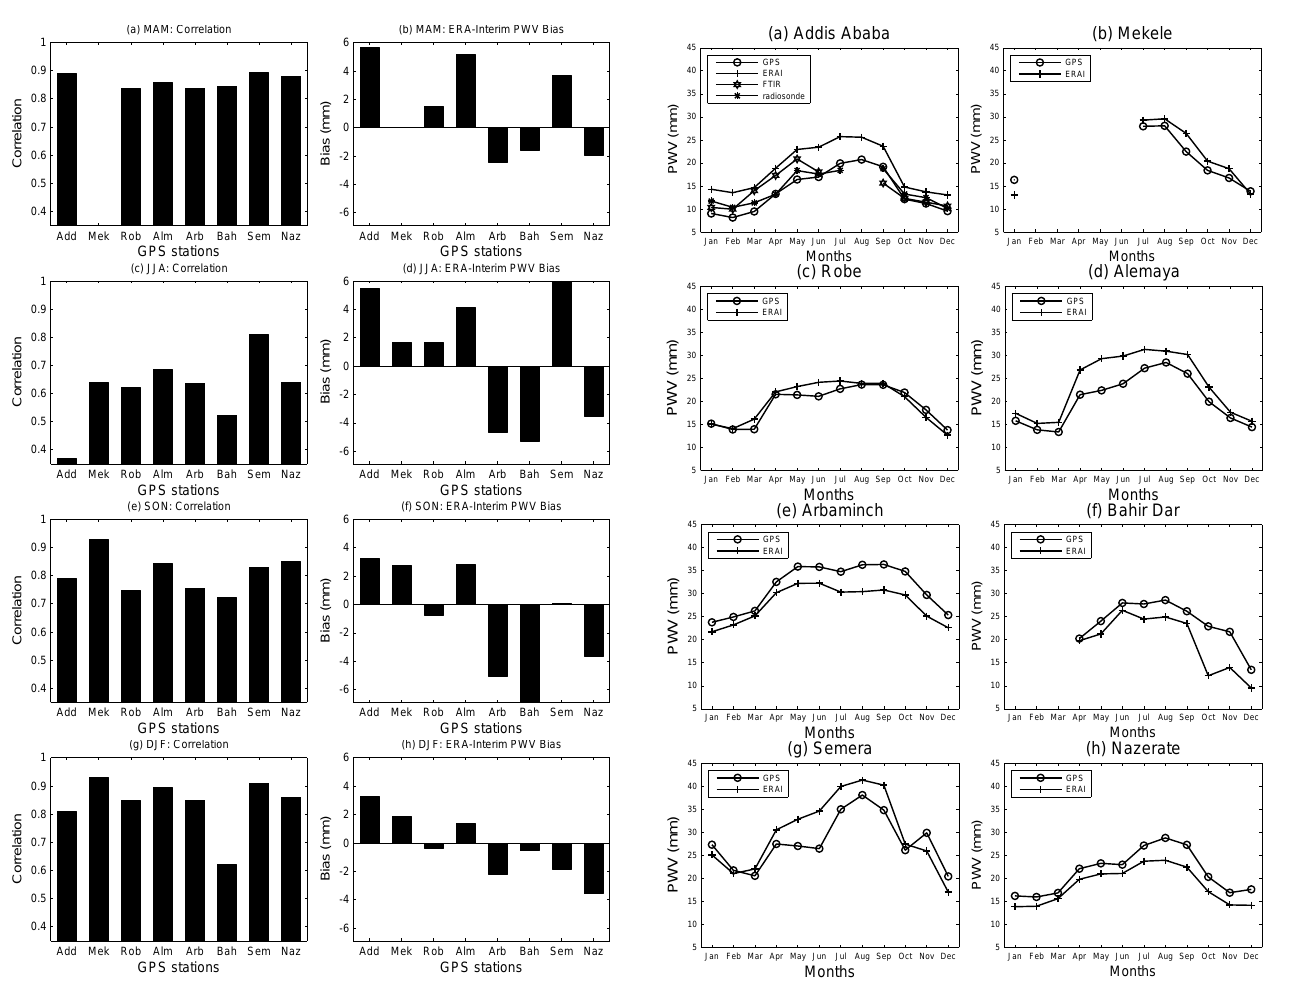
Figure 12. The seasonal water vapour cycle as captured by different data sets at Addis Ababa (a) , and by ERA-Interim and GPS at the remaining seven GPS sites (b–h)